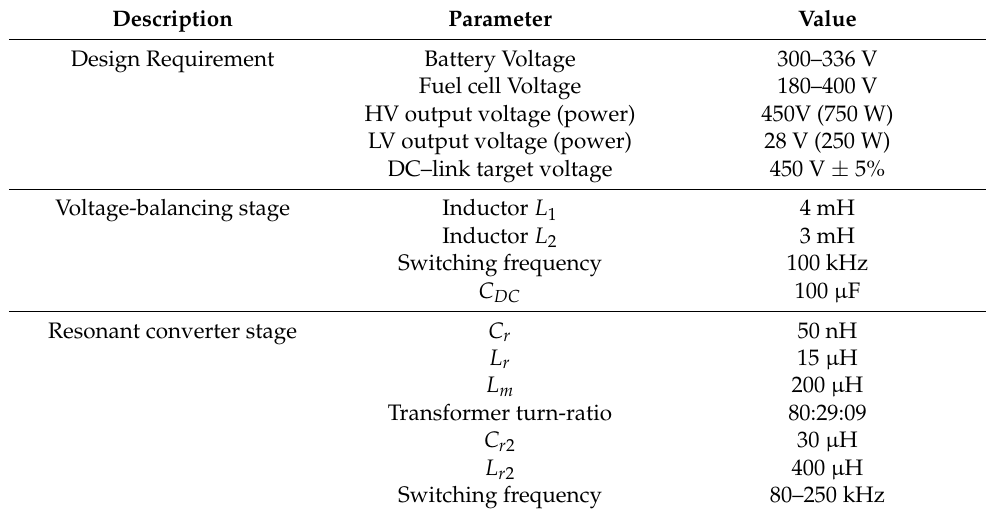
Table 8. Design requirement parameters and designed parameters of the voltage–balancing stage and the resonant converter